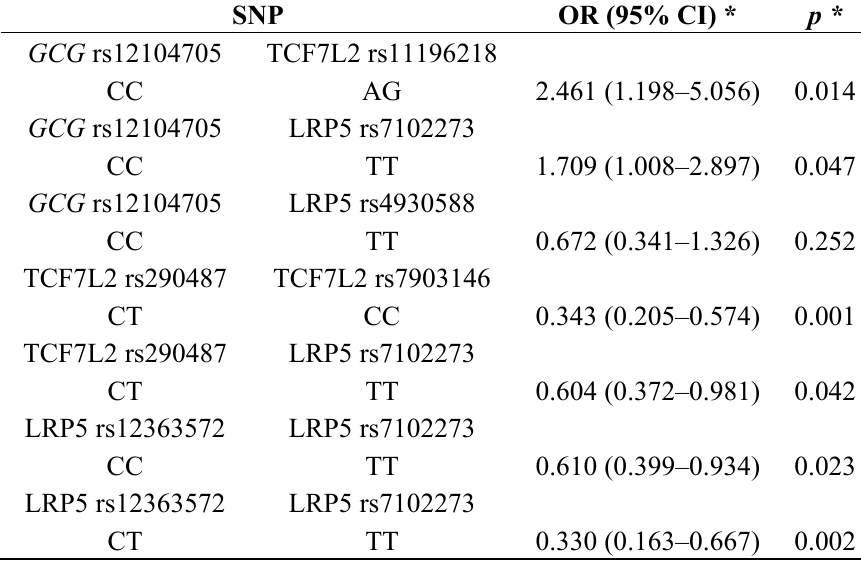
Table 11. Interactions of SNPs in LRP5 , TCF7L2 , and GCG gene for T2DM by the multiplicative logistic